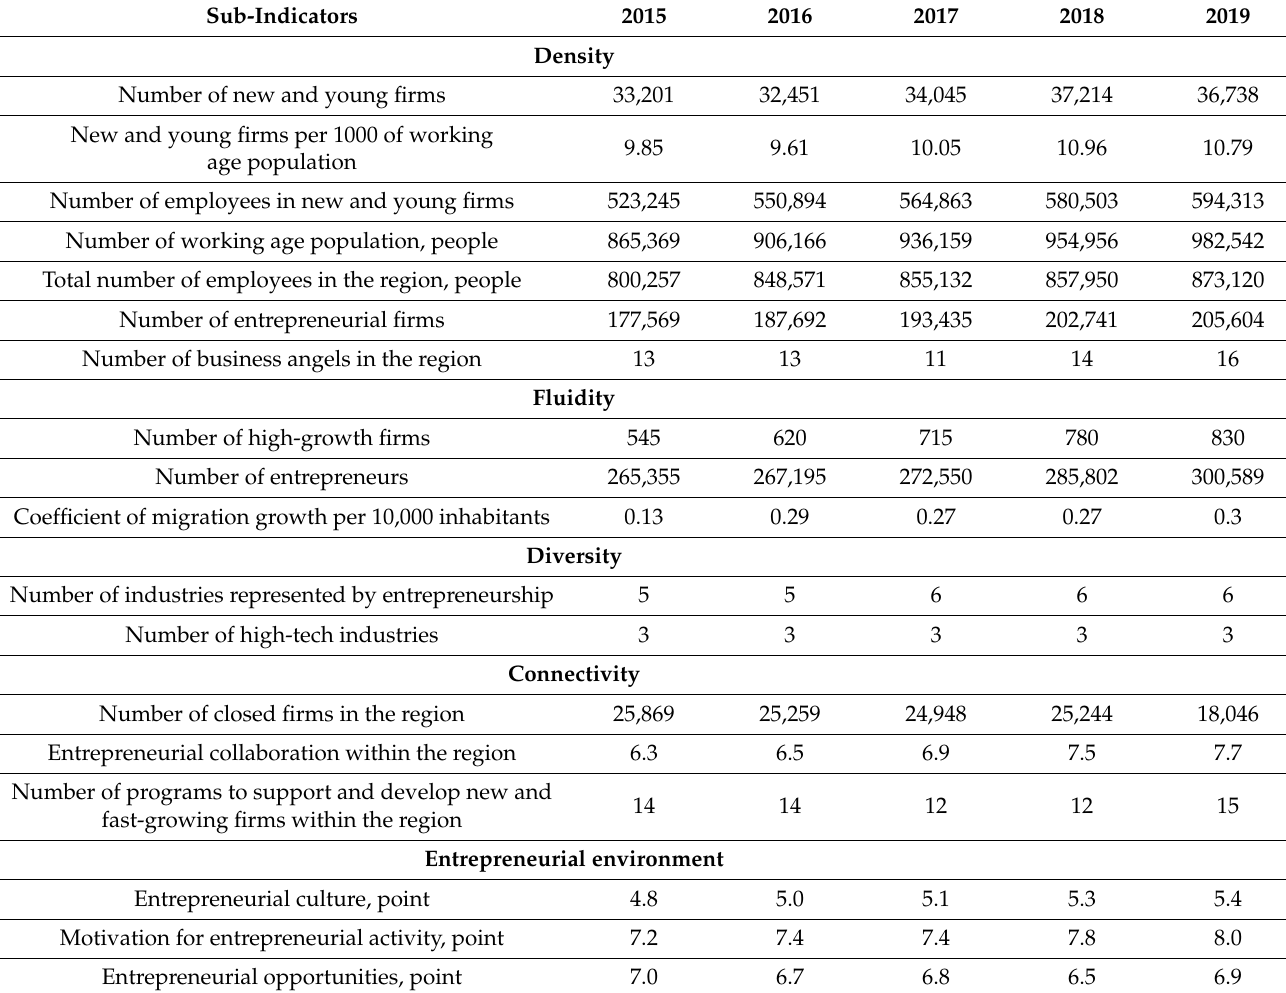
Table 4. Initial data for assessing the maturity of the Małopolska region entrepreneurial ecosystem.